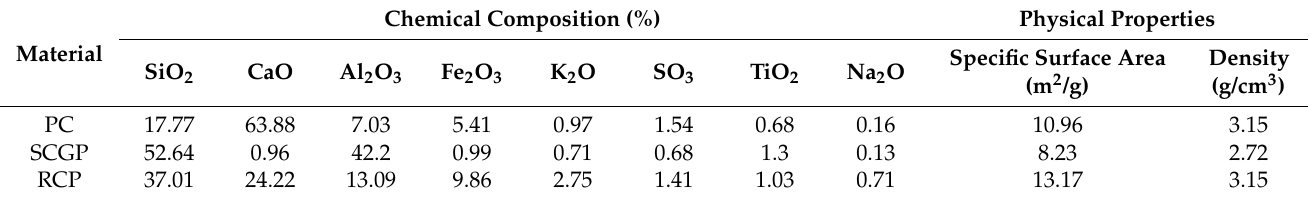
Table 1. Properties of cementitious materials (PC, SCGP, and RCP).